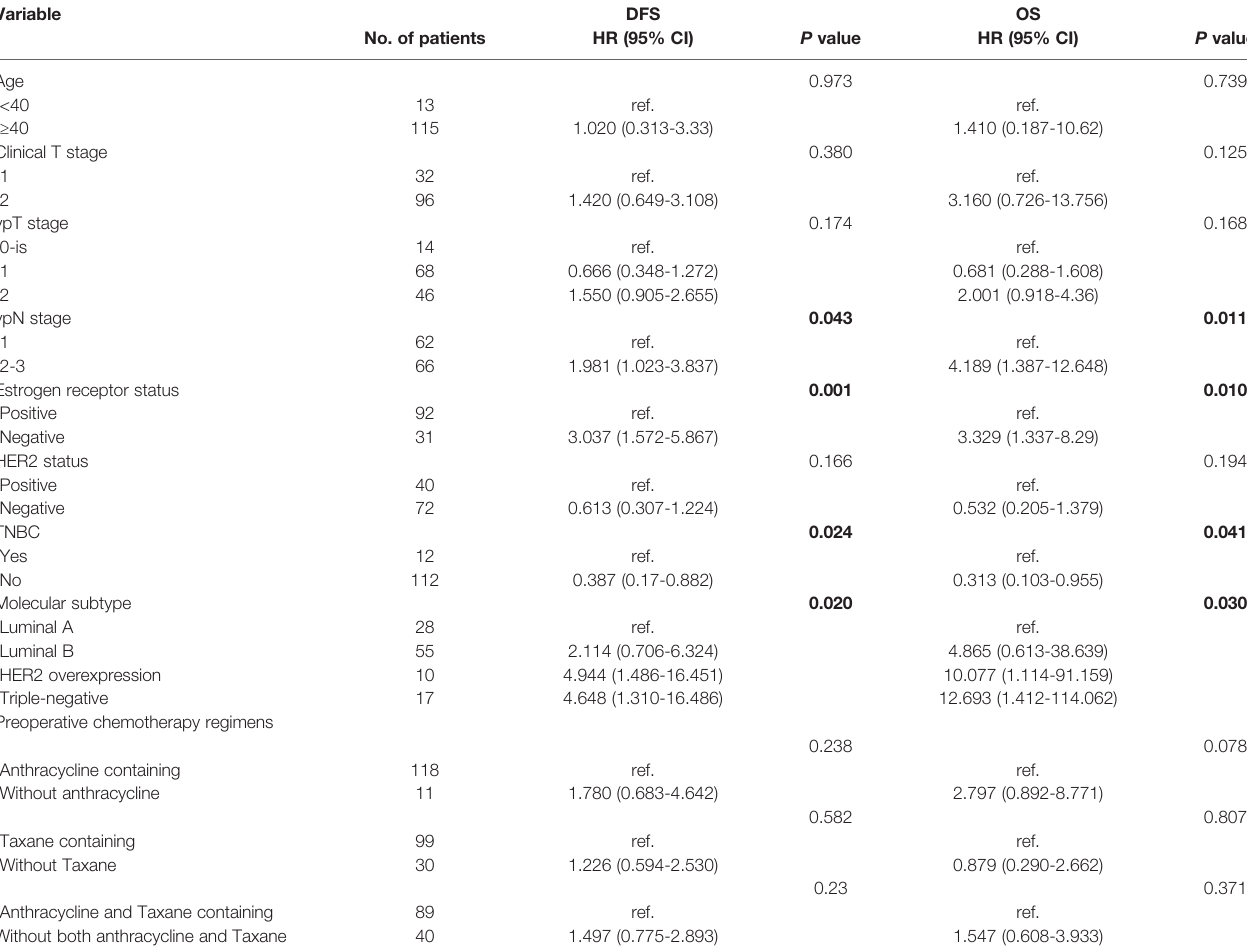
TABLE 4 | Univariate analysis of factors associated with DFS and OS in the ypT 0-2 N + PMRT subgroup. Variable